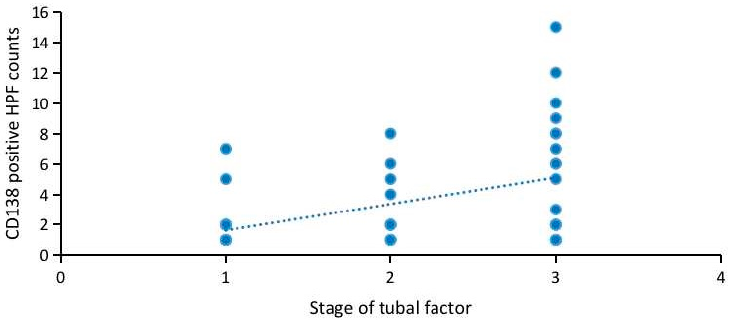
Figure 2. Correlation between CD138-positive HPF counts and stage of tubal factor in women with CE ( n = 52). CE ( n =